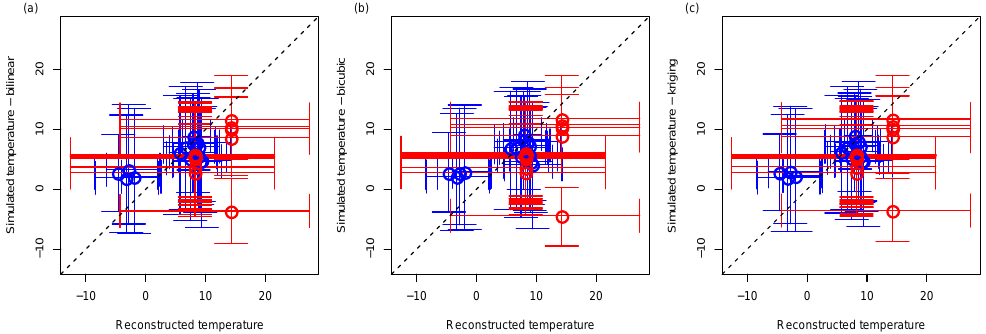
Figure 6. Comparison of reconstructed vs. downscaled temperatures for the LGM based on the BCI indices (red), and from Wu et al. (2007)’s reconstructions (blue) for (a) the bilinear, (b) the bicubic and (c) the kriging interpolations. The circles represent the mean temperature values for the two reconstruction methods ( x axis) and the downscaled values over the 50 simulated years ( y axis). The horizontal error bars represent the range of temperature values for the reconstruction method (minimum and maximum over the whole zonobiome for the BCI indices; mean temperature of the coldest and warmest months for Wu et al., 2007). The vertical error bars correspond to the mean temperature of the coldest and warmest months over the 50 simulated